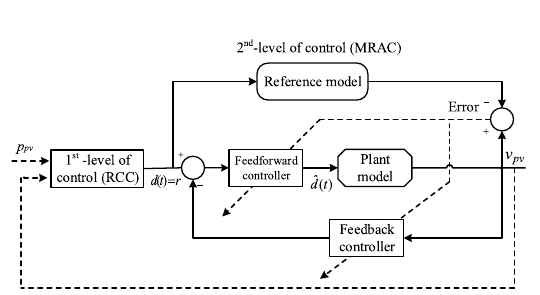
Figure 3. Representation of 2-level MPPT MRAC control architecture 2